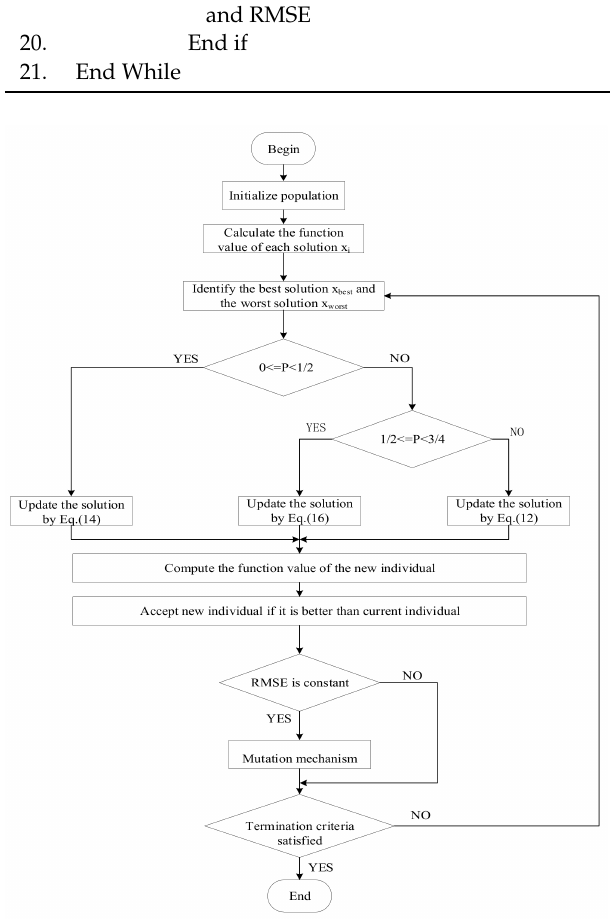
Figure 4. The flowchart of